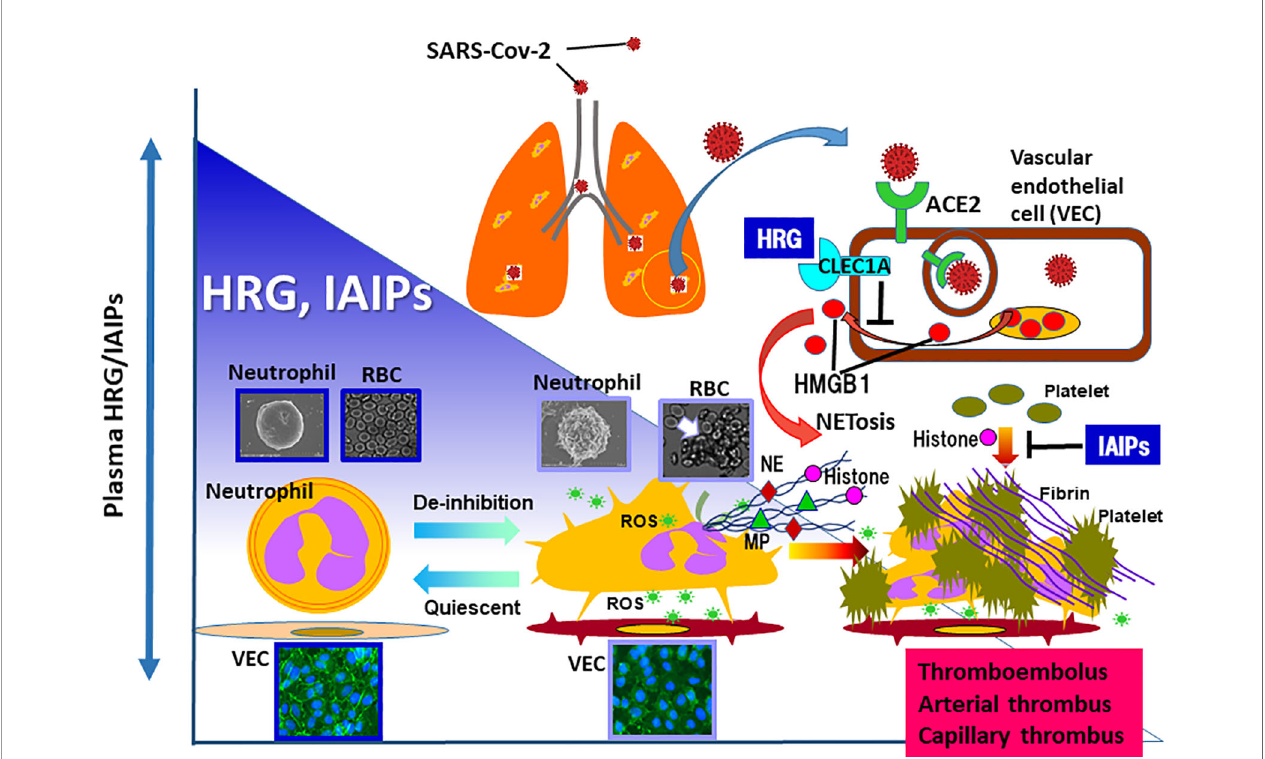
FIGURE 1 | In the animal models of sepsis as well as septic patients, the remarkable decrease in plasma levels of HRG and IAIPs are evident. HRG controls the shape and function of neutrophils and inhibits NETosis in neutrophils. In addition, HRG protects vascular endothelial cells from excessive activation by inhibiting HMGB1 release from the cells, which was mediated by the stimulation of CLEC1A. IAIPs also inhibit histone-induced platelet aggregation and exert protective effects on vascular endothelial cells. Rapid decreases in plasma HRG and IAIPs will diminish these homeostatic effects, leading to immunothrombosis. Therefore, it is particularly important to ascertain changes in plasma levels of HRG and IAIPs in patients with COVID-19. ROS, reactive oxygen species; NE, neutrophil elastase; MP,